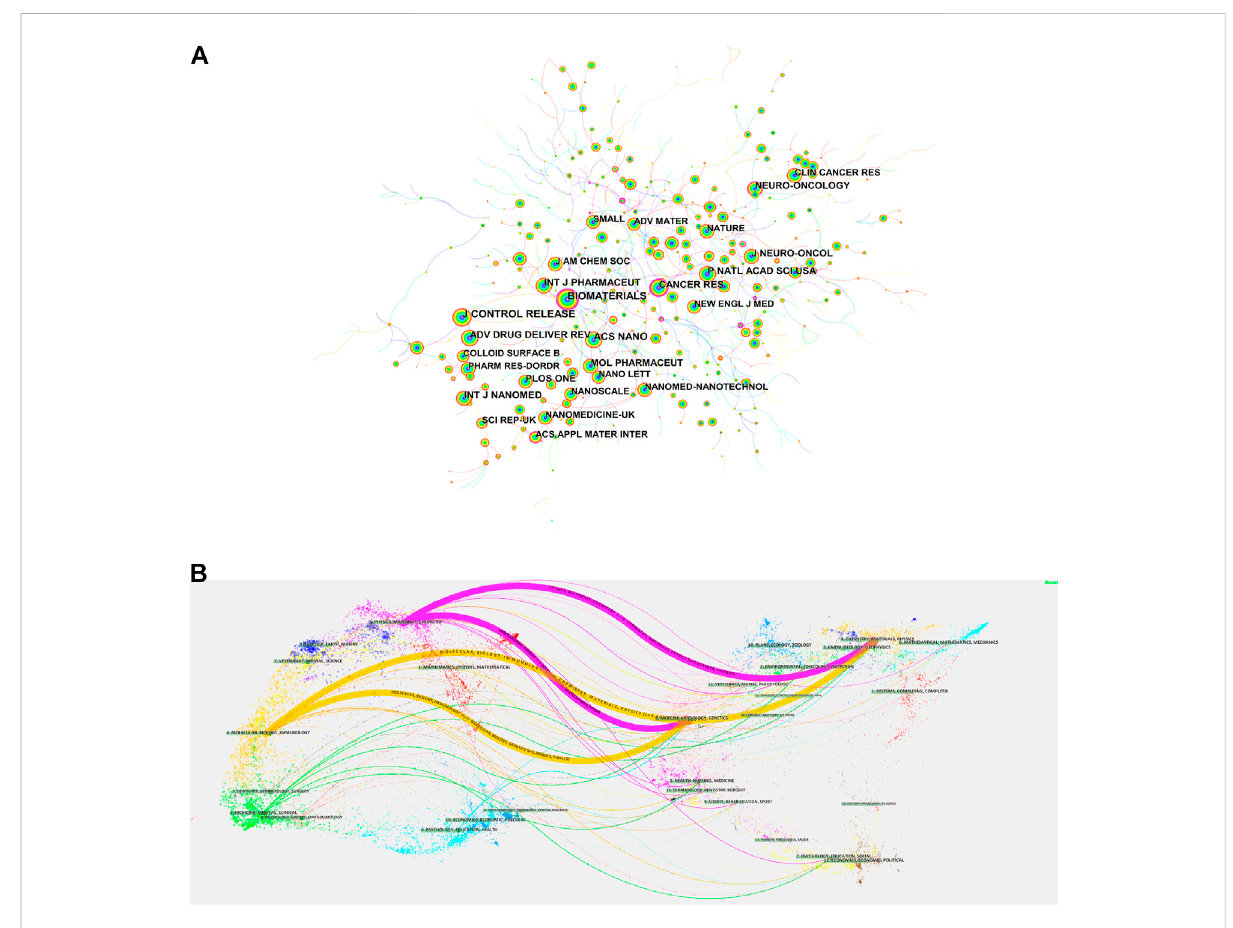
FIGURE 5 (A) Visual mapping of co-cited journals of related literature. (B) Dual-map overlay of related publications